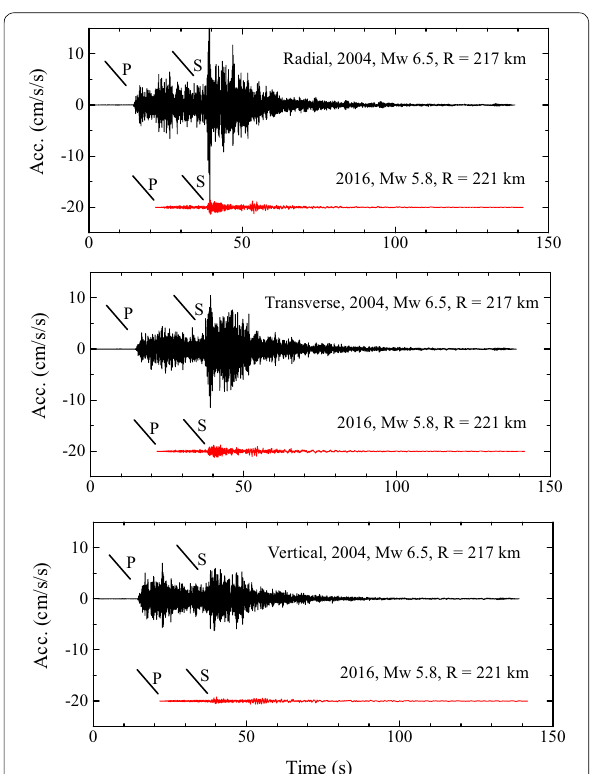
Radial, 2004, Mw 6.5, R = 217 km